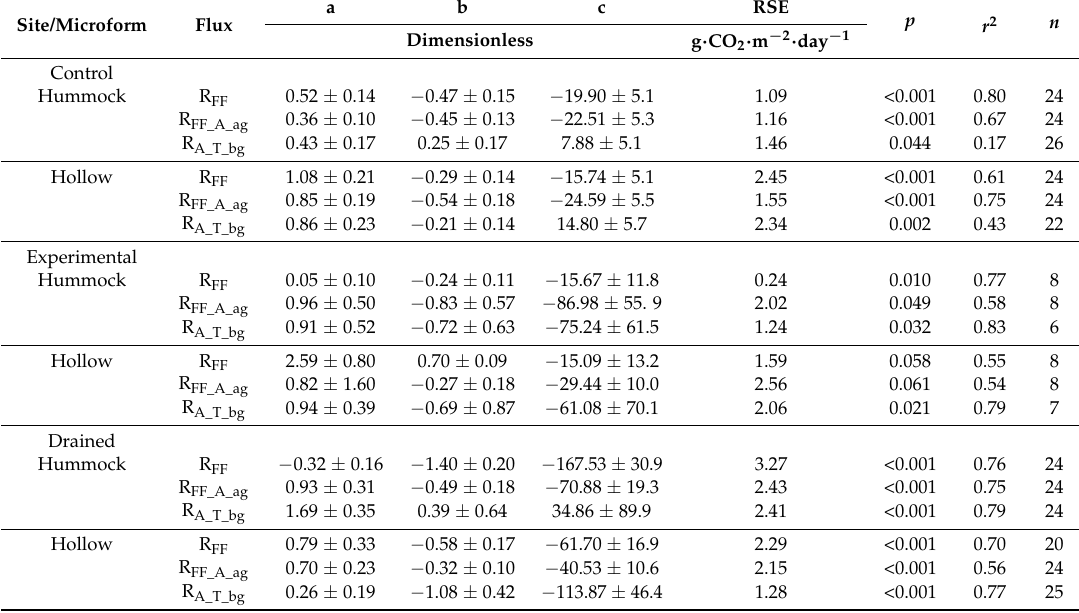
Table 1. Fitted model parameters, their values ( ± SE), residual standard error (RSE), p values, adjusted r 2 , and the number of values ( n ) included in the regression analyses for the forest floor respiration (R FF ), forest floor aboveground autotrophic respiration (R FF_A_ag ), and belowground autotrophic respiration of tree roots (R A_T_bg ) models (Equation (2))